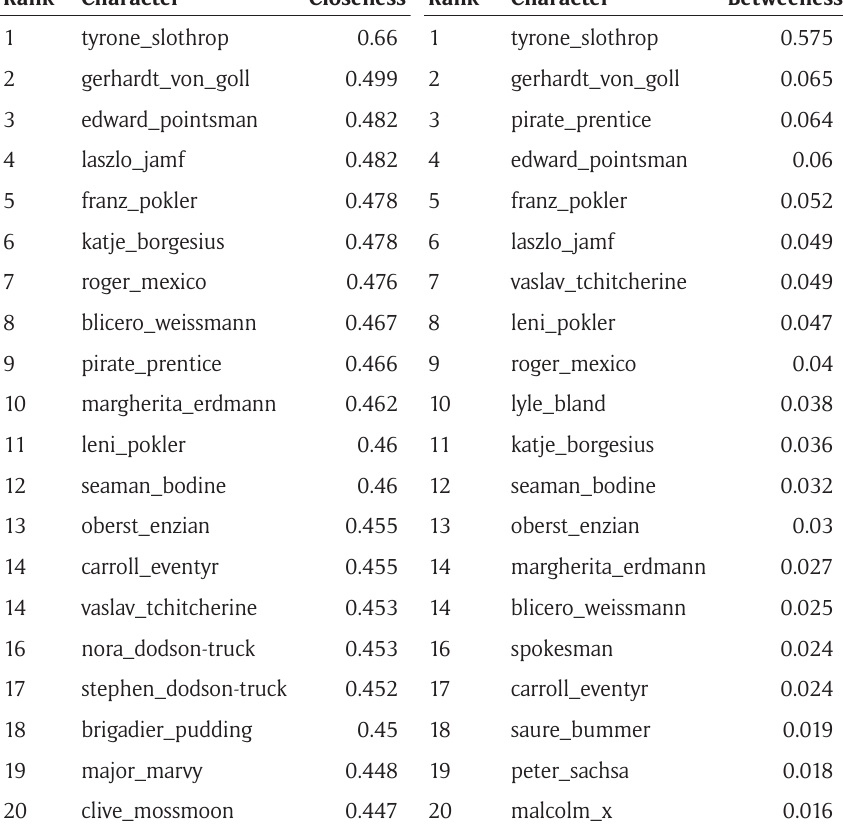
Table 3: Gravity’s Rainbow: Complete Network Closeness and Betweenness